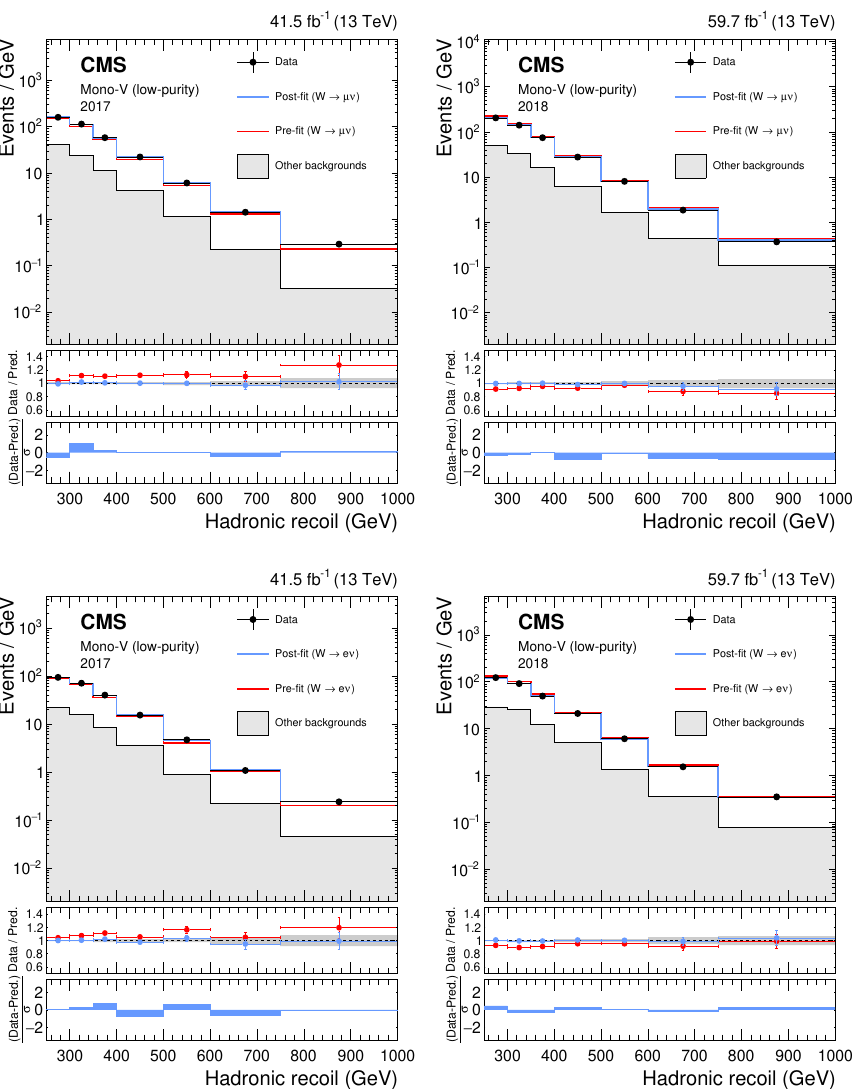
Figure 16 . Hadronic recoil distributions in the single muon (upper), and single electron regions (lower) in the low-purity mono-V category. The “Other backgrounds” include top quark, diboson, and QCD multijet